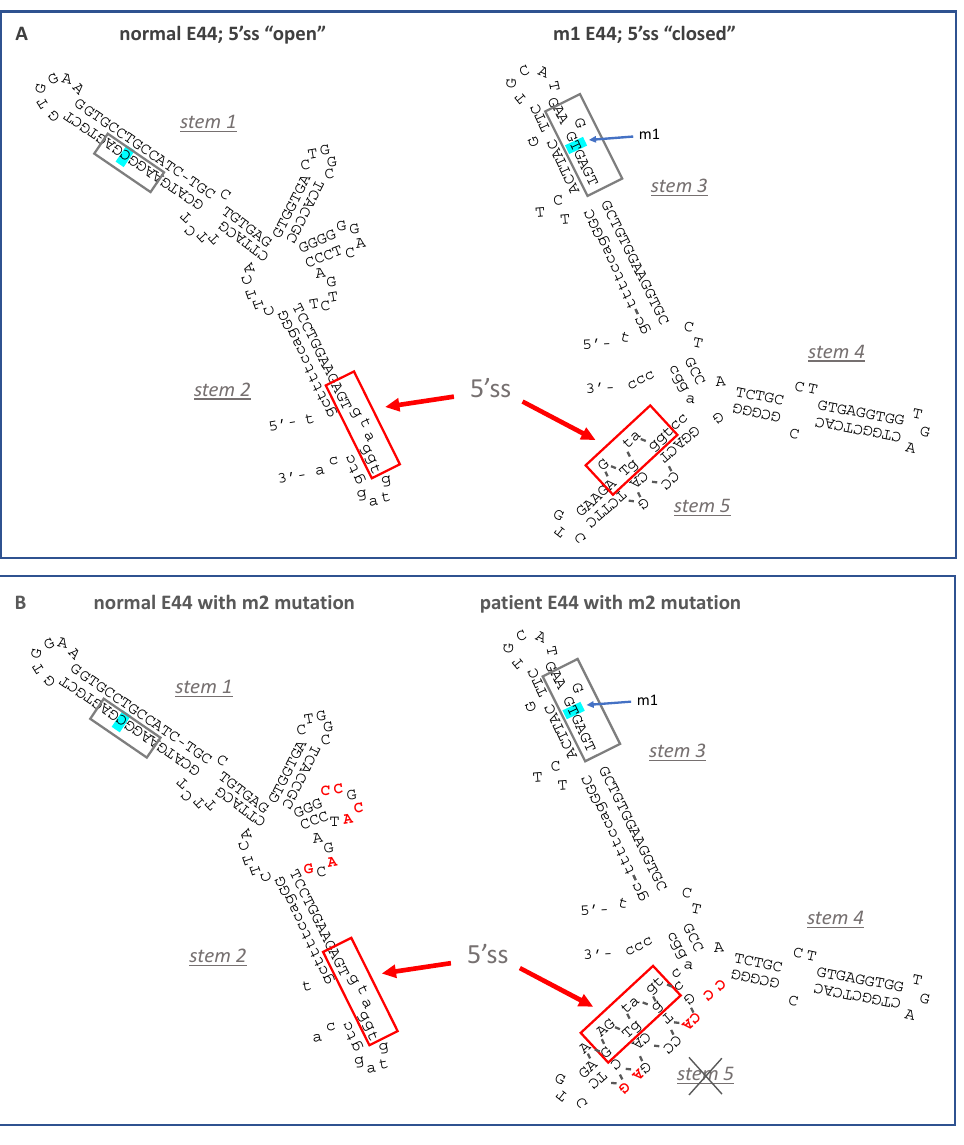
Figure 2. ( A ) Predicted structure of wild-type E44 (“open 5 ′ ss”) and patient E44 (“closed 5 ′ ss”), redrawn from [31]. 5 ′ splice site motifs are boxed, and annotation of stem structures has been added for clarity. ( B ) Superimposition of m2 mutations (red text) on normal “open” and patient “closed” conformations for E44 shown above. M2 mutations are predicted to disrupt stem 5, increasing accessibility of the 5 ′ ss.